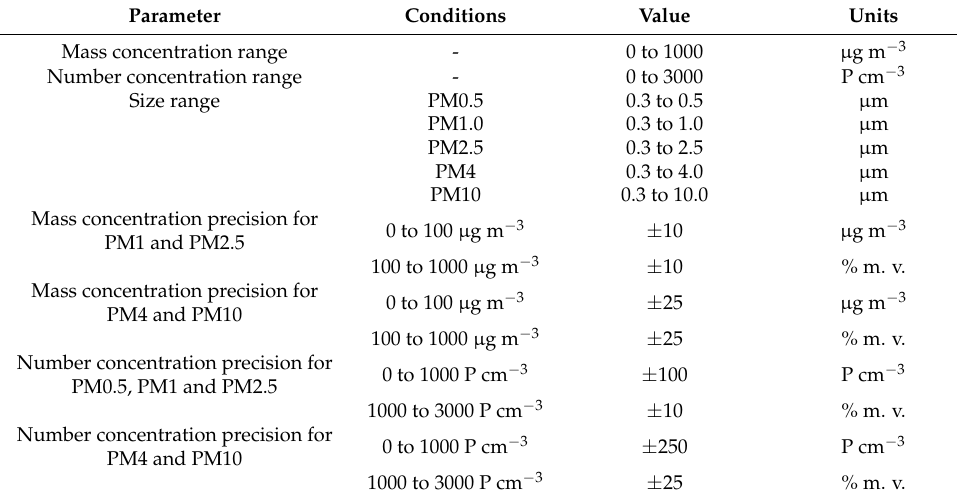
Table 1. Sensirion SPS30 sensor performance